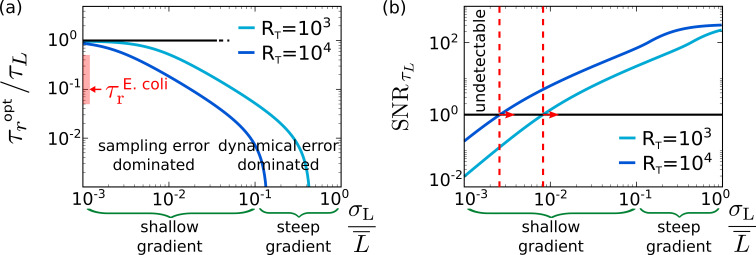
The optimal integration time for the chemotaxis system of E. coli.(a) The optimal integration time τropt, obtained by numerically optimizing Equation 8 with h=RT⁢τr/τc, as a function of the relative strength of the input noise, σL/L¯, for two different copy numbers RT of the receptor–CheA complexes; for an exponential gradient with length scale x0, the relative noise strength σL/L¯≃l/x0, where l≈50⁢μ⁢m is the run length of E. coli. It is seen that τropt increases as σL/L¯ decreases because the relative importance of the sampling error compared to the dynamical error increases. The figure also shows that τropt decreases as RT is increased because that allows for more instantaneous measurements (see also Figure 3). The red bar indicates the range of the estimated integration time of E. coli, 50⁢m⁢s<τr<500⁢m⁢s, based on its attractant and repellent response, respectively (Sourjik and Berg, 2002), divided by the input timescale τL≈1⁢s based on its typical run time of about a second (Berg and Brown, 1972; Taute et al., 2015). The panel indicates that E. coli has been optimized to detect shallow concentration gradients. (b) The signal-to-noise ratio SNRτL=(σL/δ⁢L^)2⁢τL/τr, with (σL/δ⁢L^)2=SNR given by Equation 6, as a function of σL/L¯≃l/x0. To be able to detect the gradient, the SNRτL must exceed unity. The panel shows that the shallowest gradient that E. coli can detect (marked with dashed red line) has, for RT=104, a length scale of x0≈25000⁢μ⁢m (corresponding to σL/L¯≈2×10-3), which is consistent with experiments based on ramp responses (Shimizu et al., 2010). Other parameter: receptor–ligand-binding correlation time τc=10⁢m⁢s (Vaknin and Berg, 2007; Danielson et al., 1994).